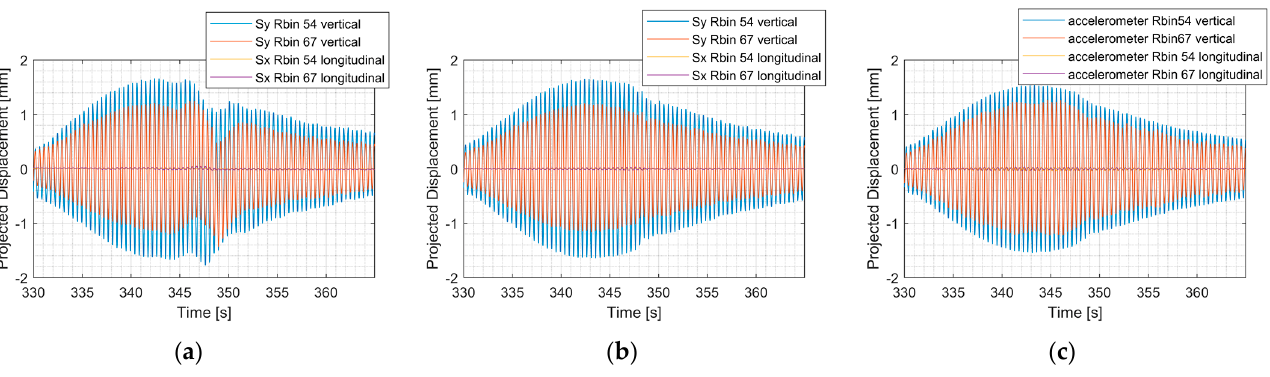
Figure 26. Effect of the quasi static components on the total displacement. Longitudinal and vertical displacements caused by the regular pace of a group of pedestrians during concurrent passage of a vehicle across the bridge: ( a ) including the quasi static component calculated by combination of both radar measurements. The irregularity of the oscillation is caused by the vehicle crossing the bridge at the same time; ( b ) without the quasi static component calculated by combination of both radar measurements. ( c ) Corresponding longitudinal and vertical displacements converted from accelerometers measurement.